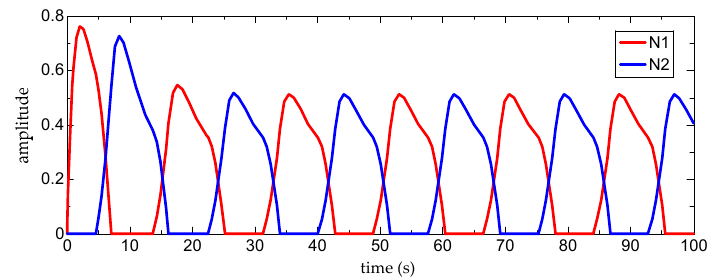
Figure 8. Reciprocal output of two neurons.